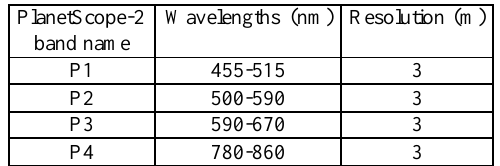
Table 3 . Spectral specificities of the PlanetScope-2 Dove.